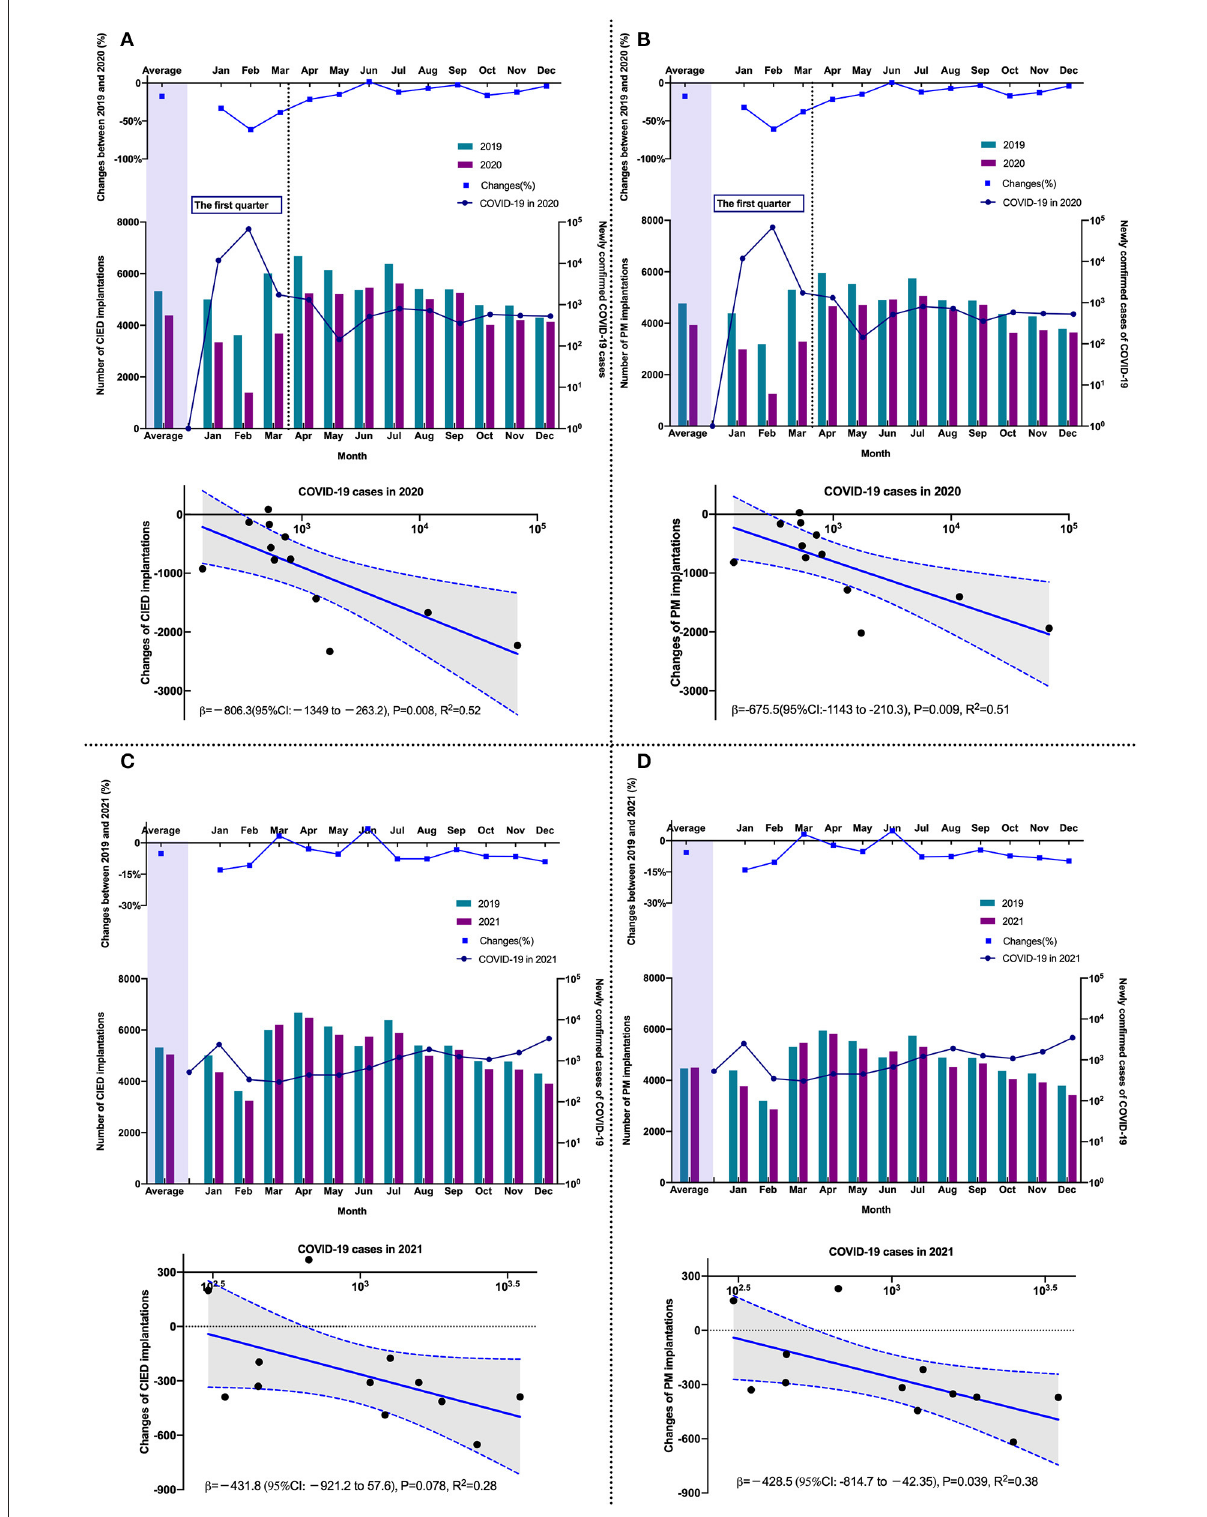
FIGURE2 The comparison of the monthly number of CIED in different periods and the relationship between changes and COVID-19 cases. (A) CIED (2019 vs. 2020); (B) PM (2019 vs. 2020); (C) CIED (2019 vs. 2021); (D) PM (2019 vs. 2021). CIED, cardiac implantable electronic device; COVID-19, Coronavirus disease 2019; PM,